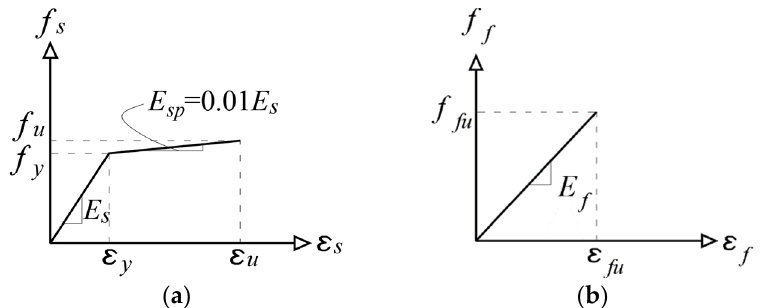
Figure 14. Reinforcement stress-strain response: ( a ) steel; ( b ) carbon and PBO fabrics.